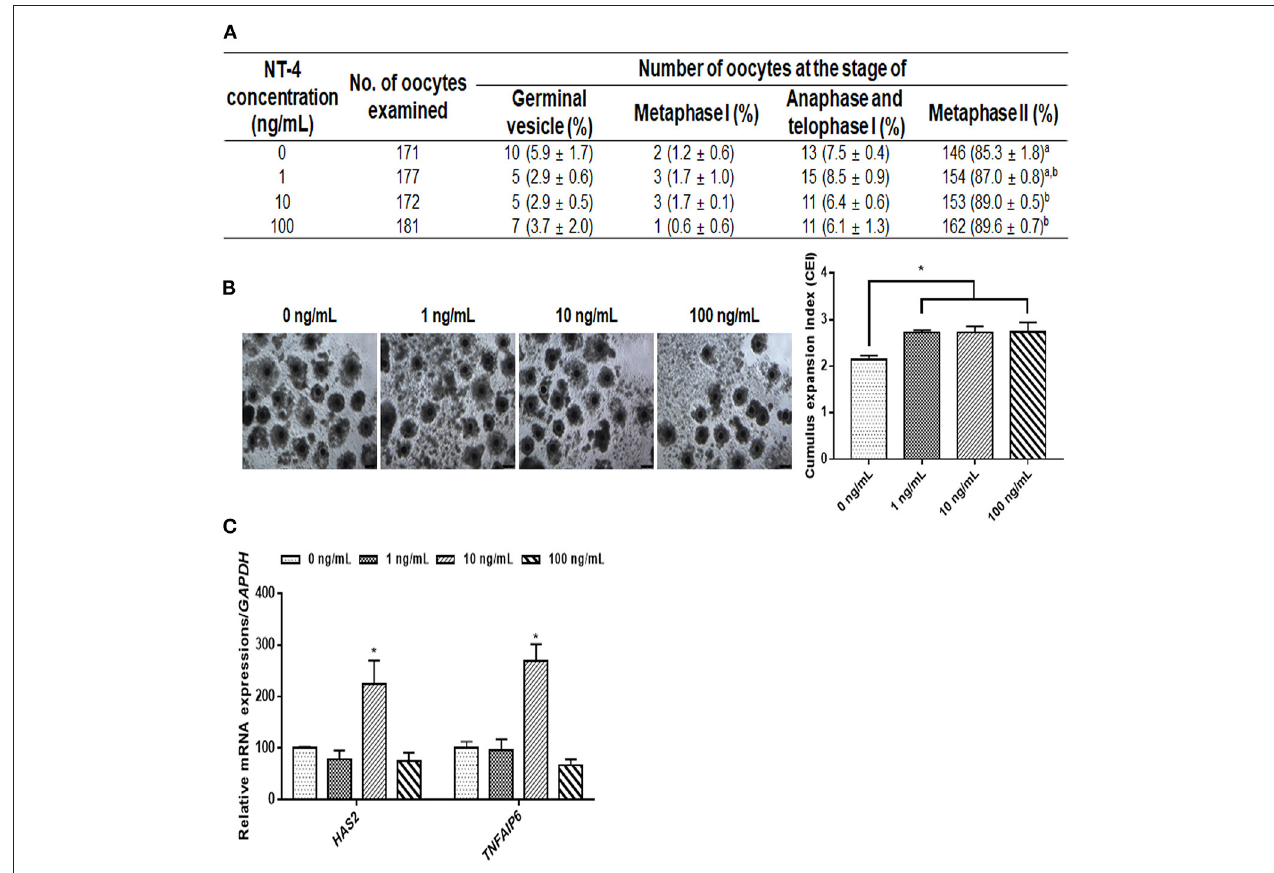
FIGURE 2 | Effect of neurotrophin-4 (NT-4) treatment with epidermal growth factor (EGF) during in vitro maturation (IVM) of oocytes and cumulus cell (CC) expansion in porcine cumulus-oocytes complexes (COCs). (A) Evaluation of nuclear maturation rate in porcine COCs treated with EGF and NT-4. a,b Values in the same column with different superscripts significantly differ ( p < 0.05). (B) Morphological CC expansion of COCs treated with EGF and NT-4 during 42h of IVM. The degree of CC expansion was examined using the cumulus scoring system: 0 (no expansion) to + 4 (maximum expansion). Scale bars = 200 µ m. (C) Expression of cumulus expansion-related genes ( HAS2 and TNFAIP6 ) in CCs treated with EGF and NT-4 during 42h of IVM. The mRNA levels were normalized to GAPDH expression as a control. All data are expressed as the mean ± SEM. All experiments were replicated with three times. Asterisks indicate statistical significance (* p < 0.05).